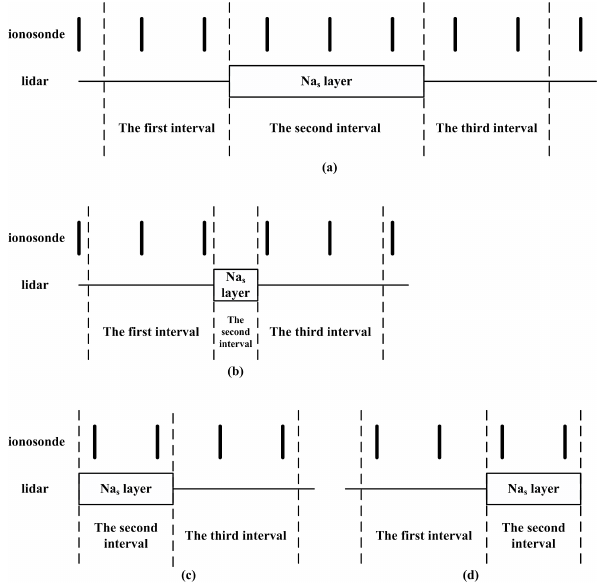
Figure 6. The definition of three time intervals around the Na s layer.